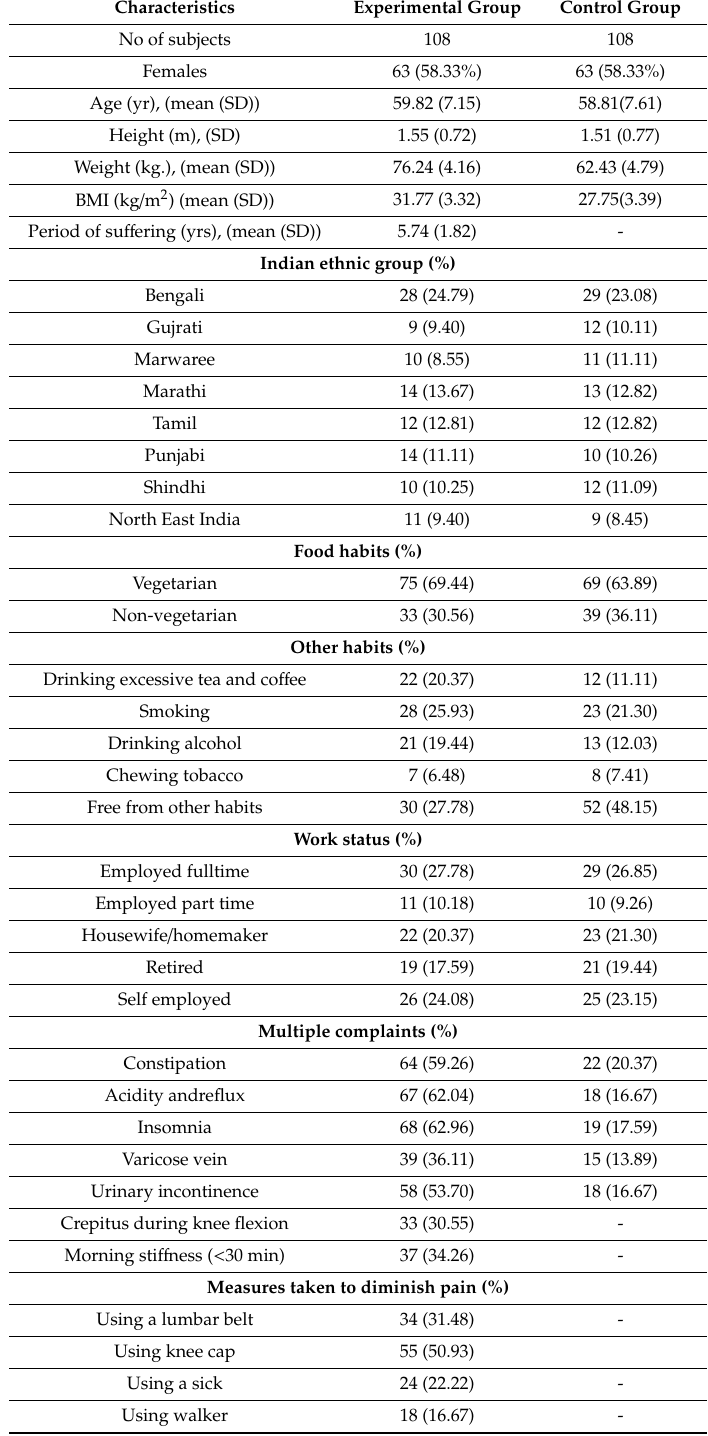
Table 1. Demographic data and baseline characteristics of